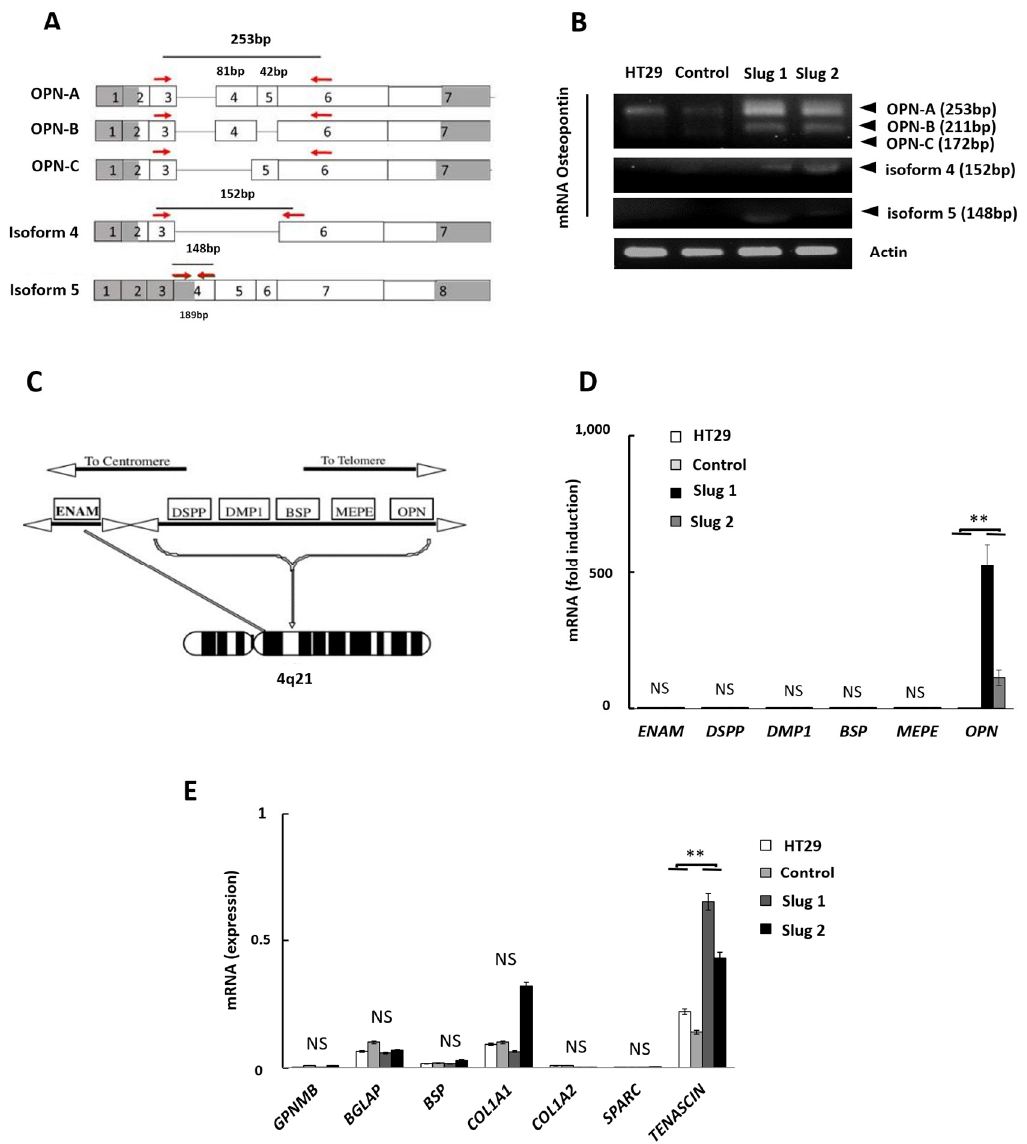
Figure 4. Slug/SNAI2 specifically increases the expression of OPN-A and OPN-B but no other SIBLING or osteogenic genes. ( A ) Diagram of the different OPN isoforms. The reading frames used as primers are indicated with red arrows. ( B ) Expression of OPN isoforms in the four HT-29 cell lines as determined by electrophoresis. Following qPCR, the different amplicons were loaded and separated on a 2% agarose-TAE gel. Actin was used for normalization. ( C ) The SIBLING family gene cluster: the order of the genes is as follows, going from the left (closest to the centromere) to the right (toward the telomere): ENAM, DSPP, DMP1, BSP, MEPE, and OPN. ( D ) qRT-PCR was performed to determine the influence of Slug on the expression of the SIBLING genes. The graph represents the mean of 3 independent experiments. The brackets indicate the difference between control and Slug1 or Slug2. Data were considered significant if p was less than 0.05, as determined by the ANOVA test. Symbols: ** p < 0.01, NS, not significant. ( E ) qRT-PCR analysis of additional osteogenic genes, including GPNMB BGLAP, BSP, COL1A1, SPARC, and TENASCIN C. The graph represents the mean of 3 independent experiments. The brackets indicate the difference between control and Slug1 or Slug2. Only the expression of tenascin C reached significance. Data were considered significant if p was less than 0.05, as determined by the ANOVA test. Symbols ** p < 0.01; NS, not significant.